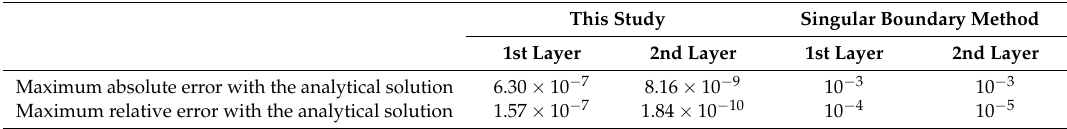
Figure 18. Comparison of results with the analytical solution. ( a ) Absolute error in the first layer, ( b ) absolute error in the second layer, ( c ) relative error in the first layer, and ( d ) relative error in the second layer. Table 2. Comparison of computed results with those from references.